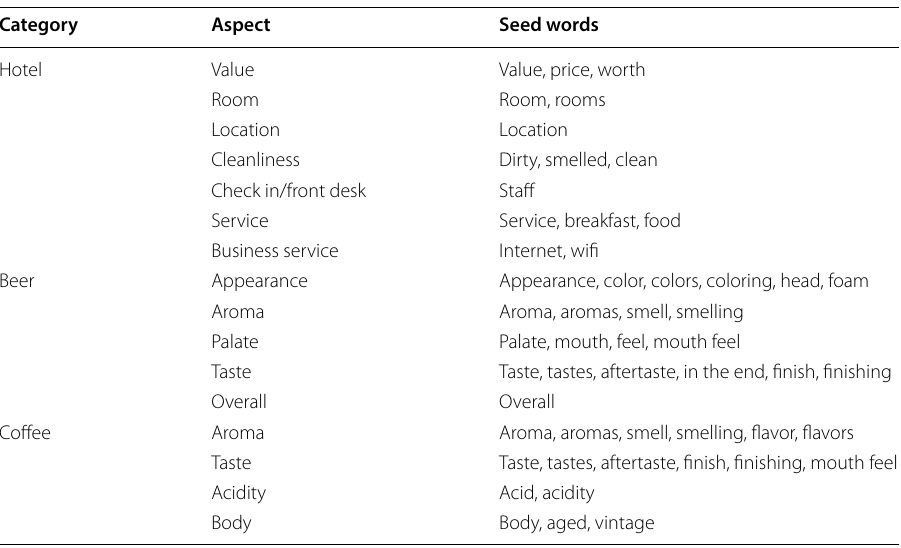
Table 4 Seed word for main aspects